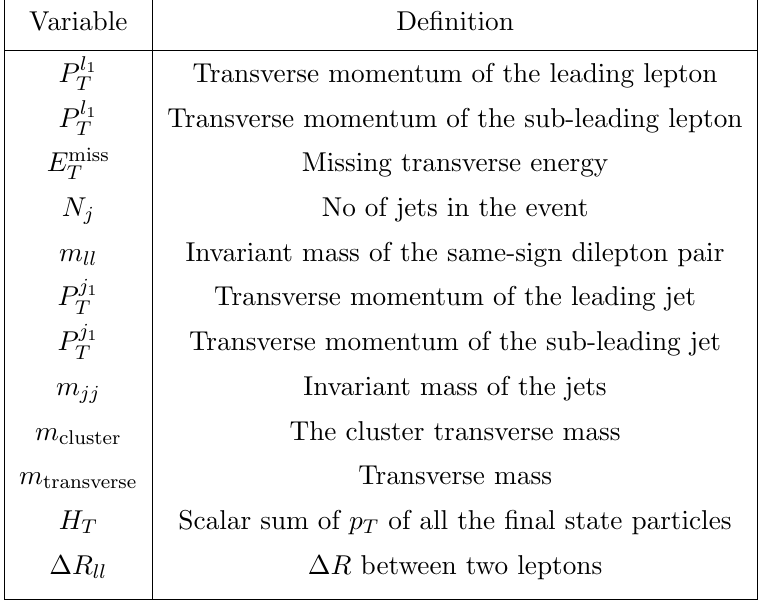
Table 7 . Feature variables for training in the XGBoost and ANN